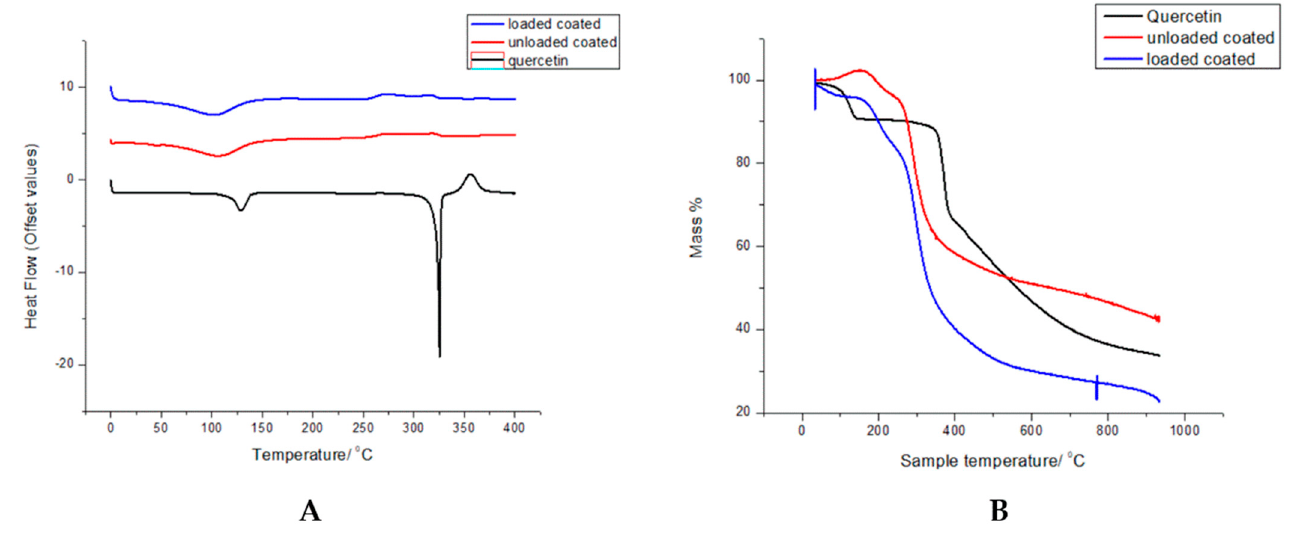
Figure 6. ( A ) DSC and ( B ) TGA thermograms of loaded and unloaded coated nanoparticles where Que = quercetin.